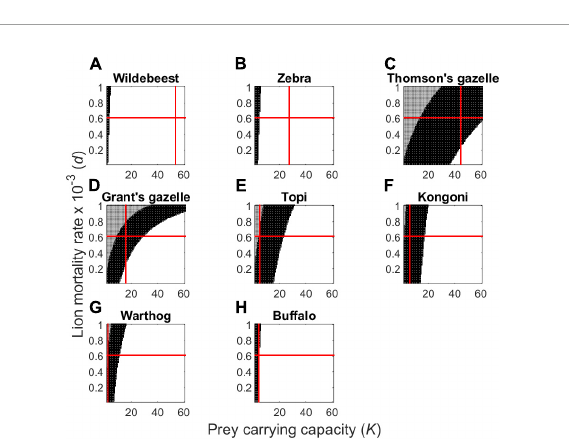
FIGURE6 Plot of dynamically unstable (unshaded), locally stable (dark shading), and unsustainable (moderate shading) outcomes for the group-dependent predator-prey model (Eqs 3, 4) as determined by predator mortality rate ( d ) and prey carrying capacity ( K ) for the most common prey of Serengeti lions, assuming that prey are solitary and randomly distributed in space. The red lines depict the values of lion daily mortality rate ( d ) and prey carrying capacity ( K ) estimated from our empirical data, showing that many of the observed values lie outside stable regions with the exception of zebra. Panels correspond to wildebeest (A) , zebra (B) , Thomson’s gazelles (C) , Grant’s gazelles (D) , topi (E) , hartebeest (F) , warthog (G) , and buffalo (H)